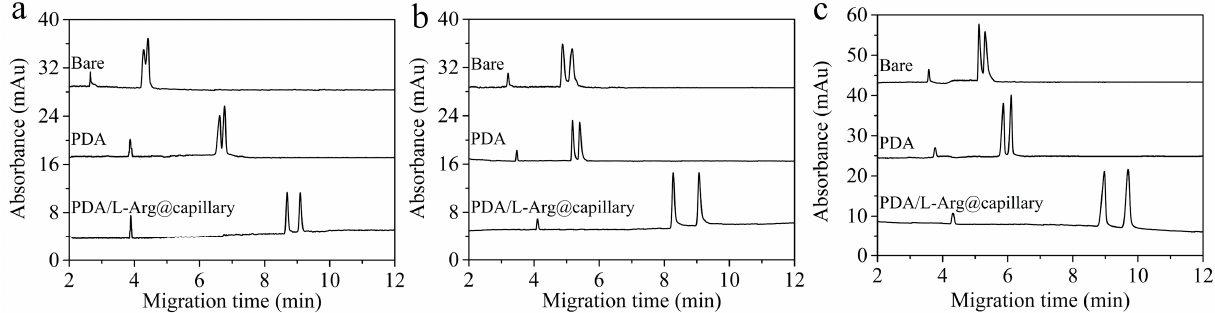
Figure 5. Electropherograms of Dns-D,L-Asp ( a ), Dns-D,L-Ser ( b ), and Dns-D,L-Ala ( c ) on bare, PDA-coated column, and PDA/L-Arg@capillary. Buffer pH at 8. Other CE experimental conditions are the same as Figure 3.